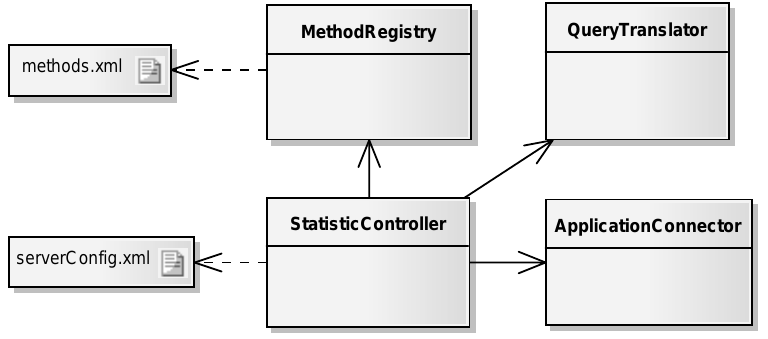
Figure 2: Class model of statistics web